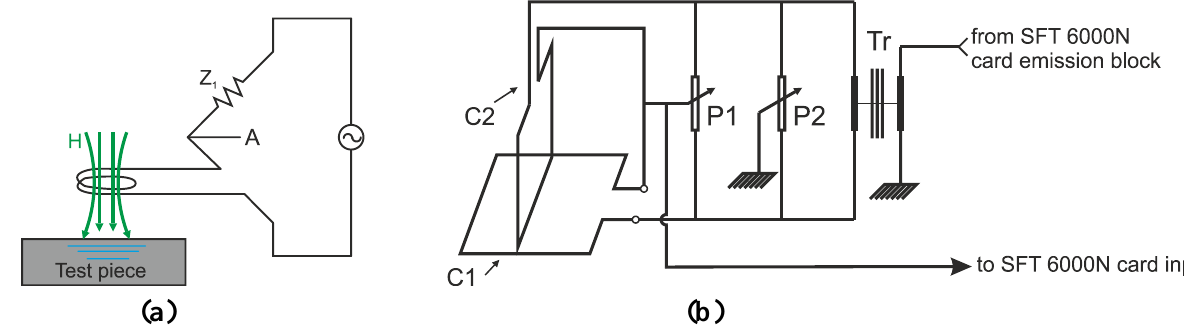
Figure 25. (a) Resistor-coil probe polarization. (b) Separate-function coil probe polarization (adapted from